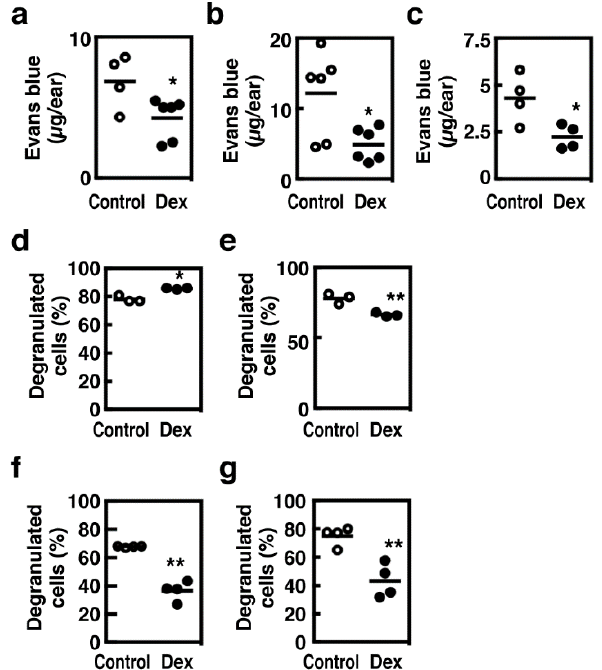
Figure 8. ( a – c ) After the daily application of 0.05% dexamethasone to the ear tissue for 6 days, extravasation in the ear tissue was evaluated by Evans blue dye leakage 24 h after the last application (Control, open circles; Dex, closed circles). Mice were subjected to IgE-dependent passive cutaneous anaphylaxis (PCA) reactions ( a ), and intracutaneous injections of compound 48/80 ( b , 30 µ g/site) or histamine ( c , 30 µ g/site). Values with * p < 0.05 are regarded as significant. ( d – g ) Mice were treated daily without (control) or with 0.05% ( d , e ) or 0.2% ( f , g ) of dexamethasone (Dex, 20 µ l/site, dissolved in acetone) on the surface of ear tissue for 6 days. Mice were then subjected to IgE-dependent PCA reactions ( d , f ) or an intracutaneous injection of compound 48/80 ( e , g , 30 µ g/site). The ear tissues were collected 3 min after the stimulation and the degrees of degranulation of cutaneous mast cells were determined based on the acidic Toluidine blue staining. Values with * p < 0.05 and ** p < 0.01 are regarded as significant.